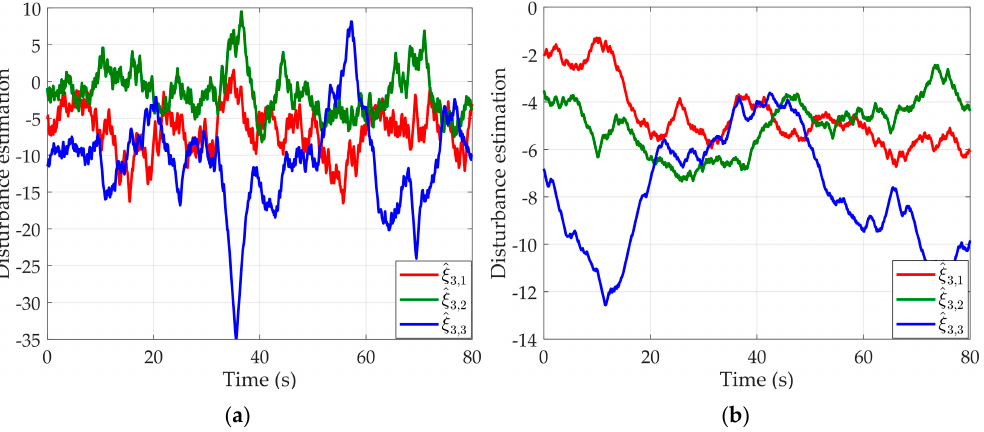
Figure 32. Curves of disturbance estimation using different control schemes: ( a ) FTADRC; ( b ) conventional ADRC.